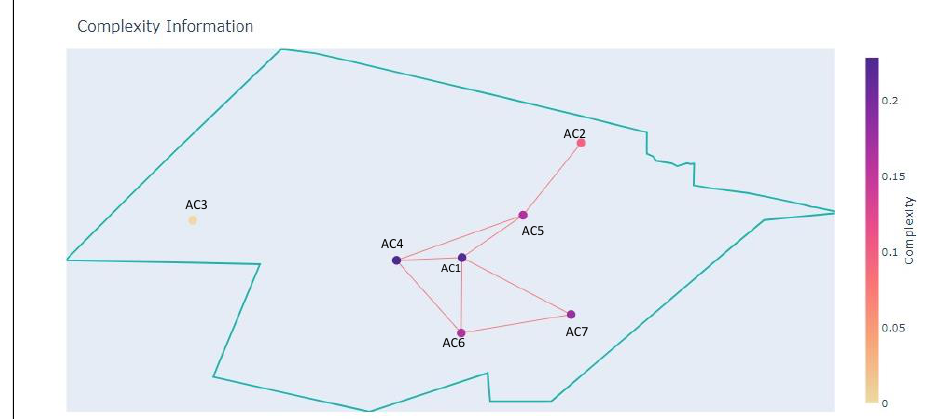
Figure 11. Sector at t 2